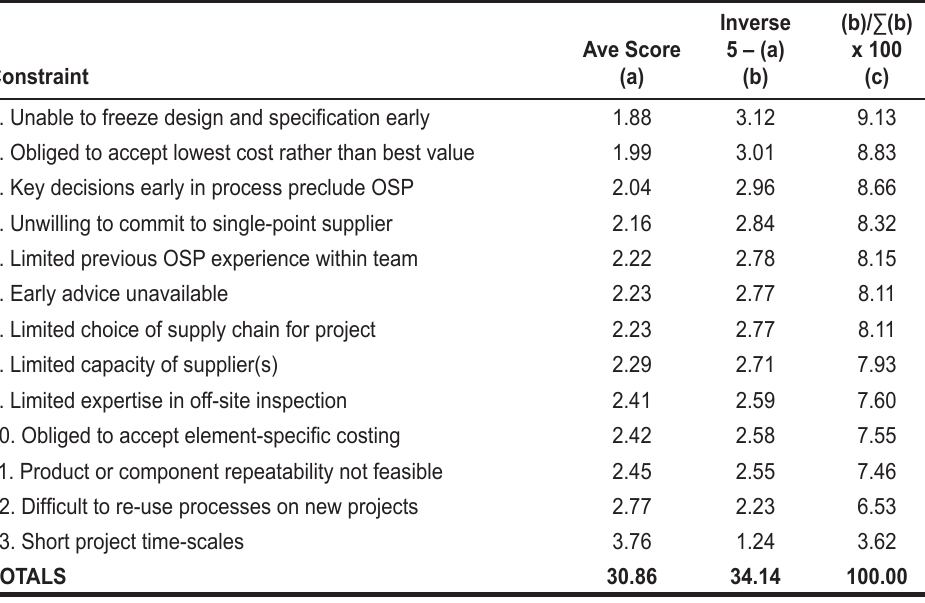
Table 3: Conversion of survey scores into penalty points for IAI